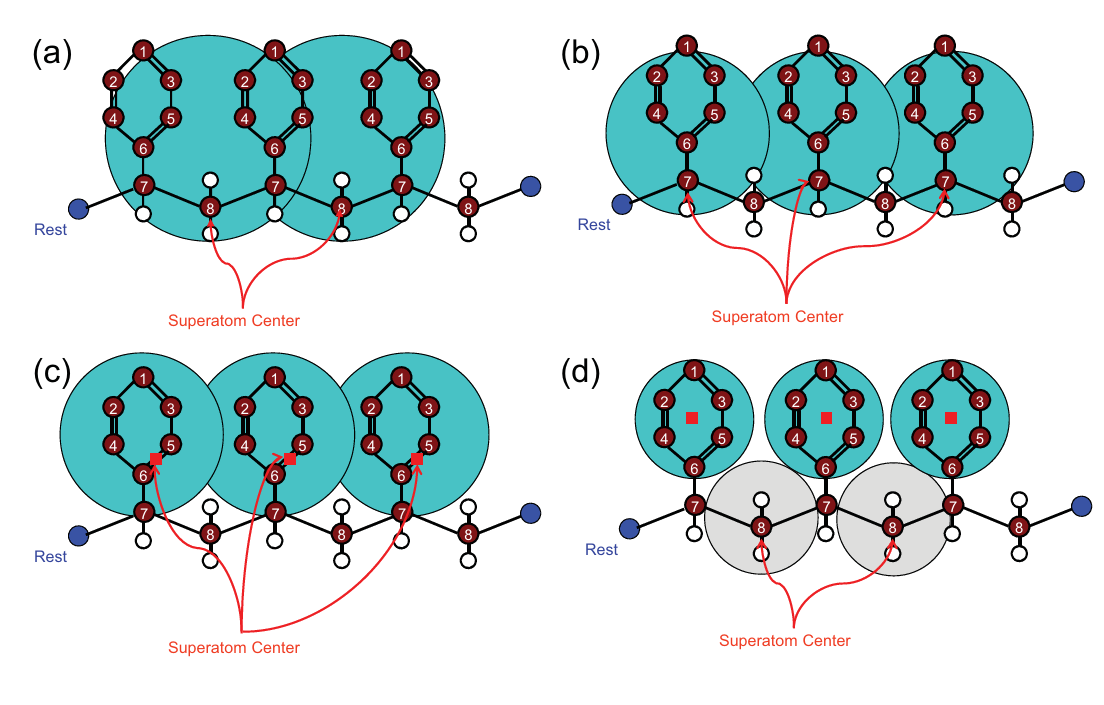
Figure 11. Different definitions for the super atoms of coarse-grained polystyrene